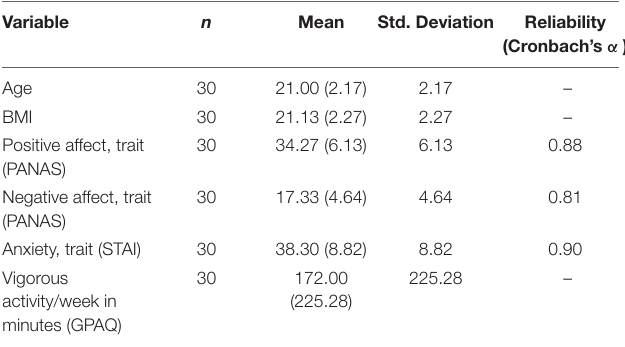
TABLE 2 | Descriptive statistics, PANAS, STAI (Trait) and regular physical activity scores (sum scores as suggested by the respective manuals) of the study